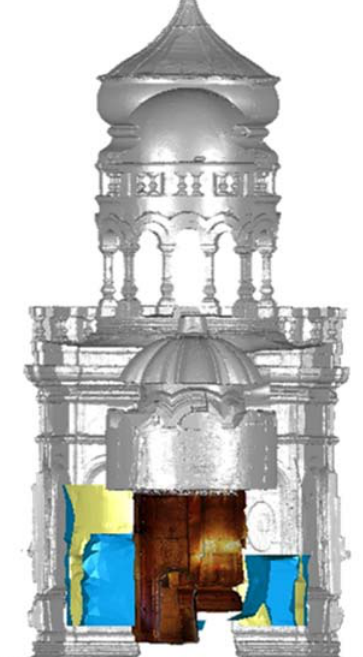
Figure 10: 3D visualization of the prospection findings: The scanned 3D model (grey) with the 3D GPR